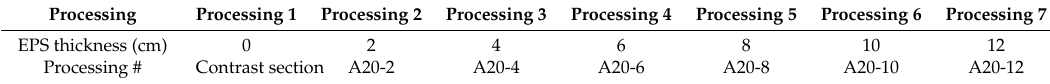
Table 1. Frost heave test processing design table.